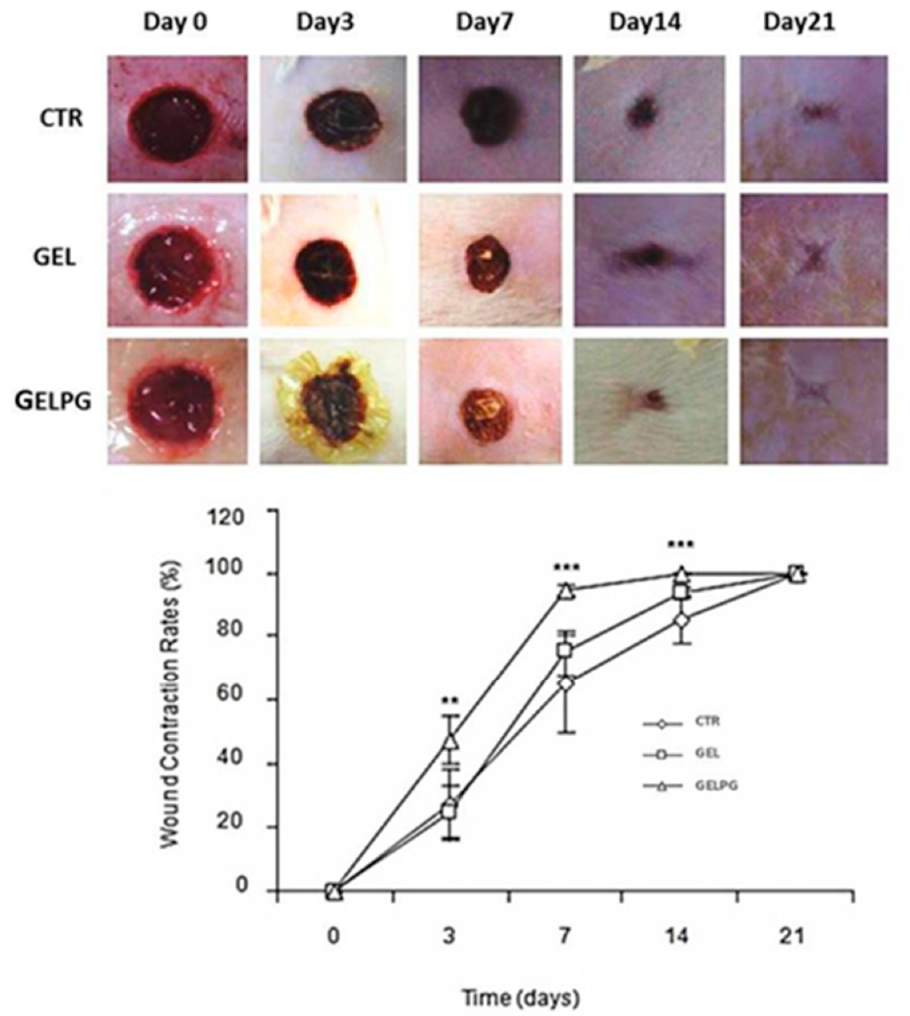
Figure 5. Macroscopic features of the wounds over a course of time, showing no abscess or hypertrophic / atrophic scar formation. A notable feature here is the retraction of the wound areas over time. The evolution of the wound contraction rates in the di ff erent experimental groups over time is shown here. ** GELPG is significantly di ff erent from CTR ( p < 0.01), and *** GELPG is significantly di ff erent from CTR ( p < 0.001).